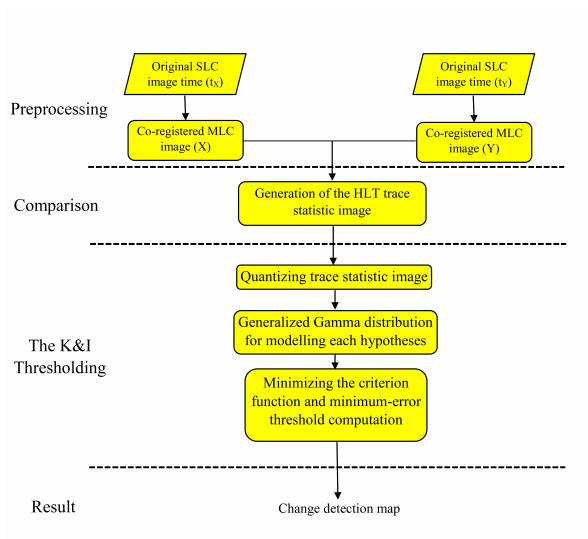
Figure 1: General block diagram of the proposed change detec- tion